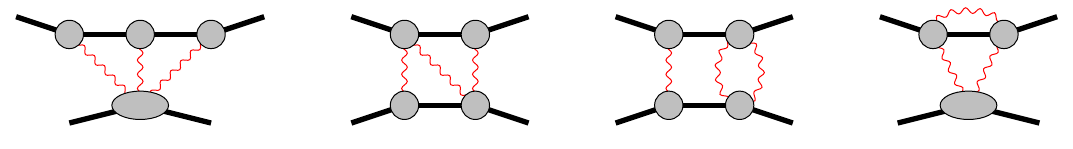
Figure 3 . Spanning set of unitarity cuts relevant for the classical dynamics at O ( α 3 )